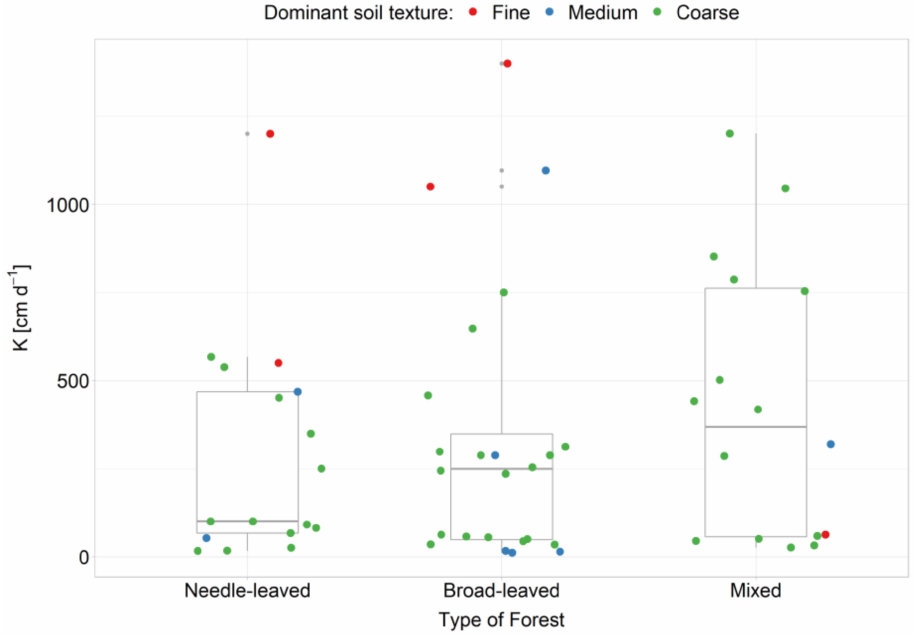
Figure 7. Descriptive statistics for dataset B top mineral soil hydraulic conductivity in terms of forest type and soil texture: fine (clay-dominated), medium (mostly loamy), and coarse (mostly sandy). Grey points represent the